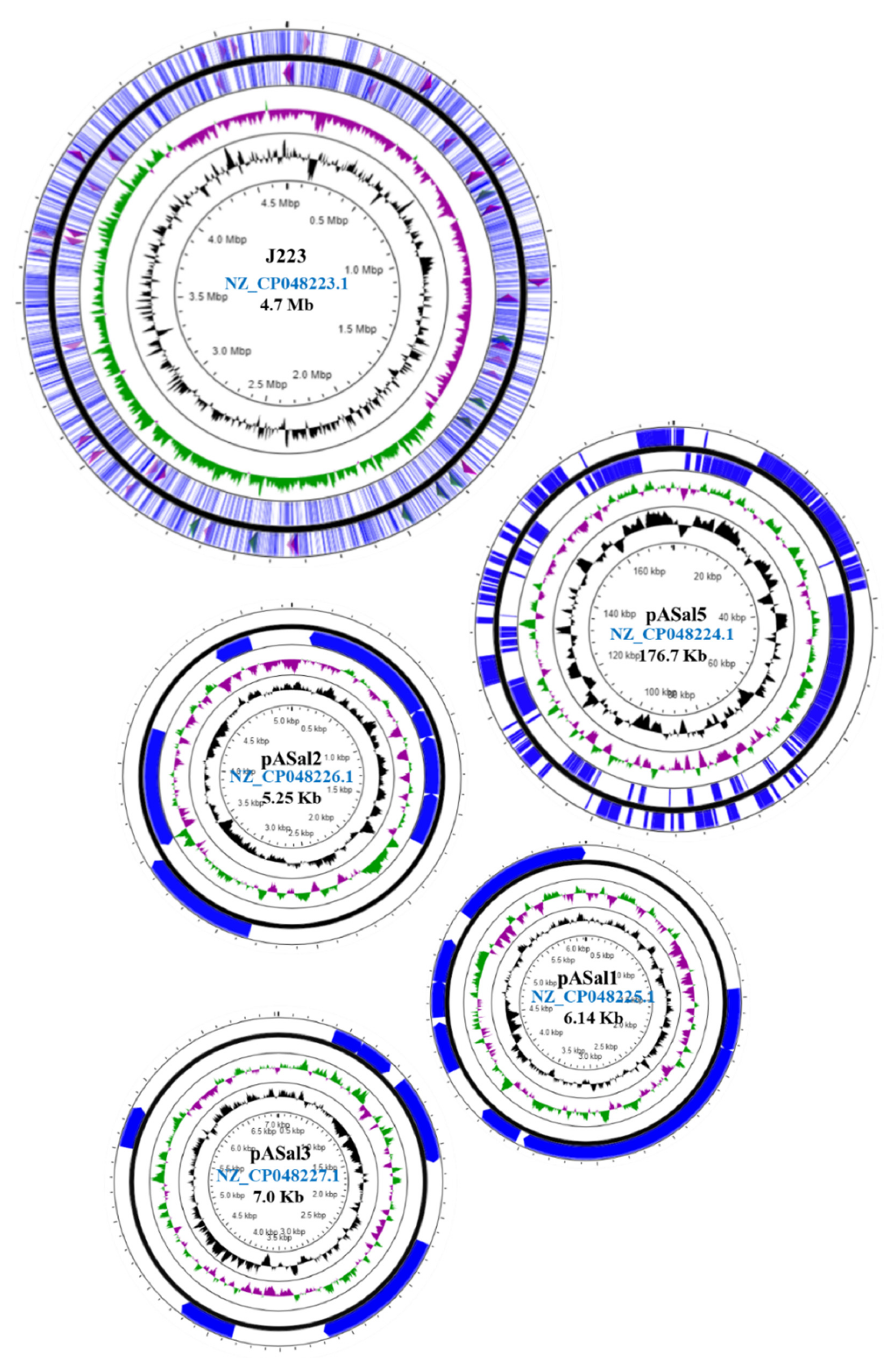
Figure 3. Typical A. salmonicida genome map. Genome map visualization of A. salmonicida J223. Map located at the upper-left represents the chromosome, and maps located below (central-right) represent the plasmids. Color bars represent CDS (blue); Color arrows tRNAs (magenta), rRNA (faint green), GC content (black), GC Skew (+) (forest green), and GC Skew ( − ) (violet).